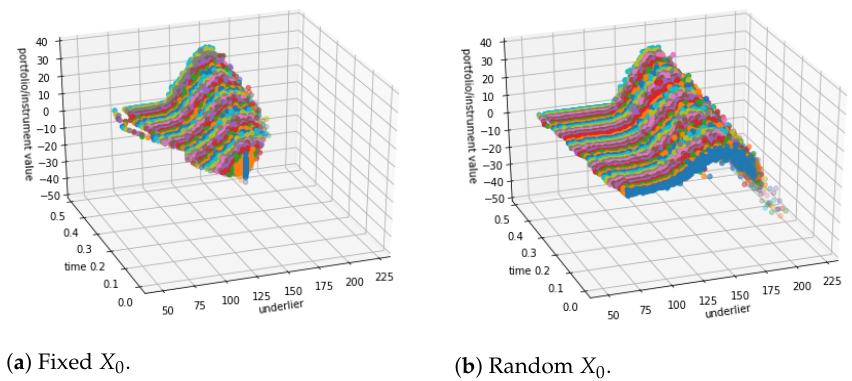
Figure 3. Y path values at 20,000 mini-batches for the batch-variance version with exact backward step (other variants look very similar) for long call combination with fixed X 0 on the left and initial network version with random X 0 on the right. Notice the much smaller coverage for fixed X 0 . Batch size 512.